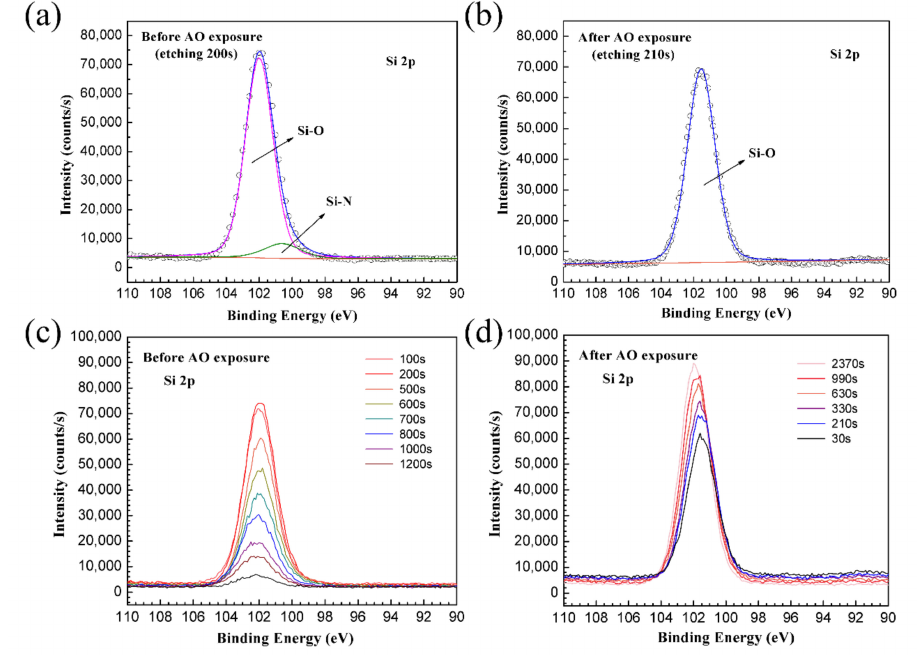
Figure 9. Deconvolution of Si 2p for ( a ) as-prepared and ( b ) AO-exposed PHPS coating, and high- resolution Si 2p XPS depth profiles of ( c ) as-prepared and ( d ) AO-exposed PHPS coating (Total fluence of AO exposure: 1.5 × 10 21 atoms cm − 2